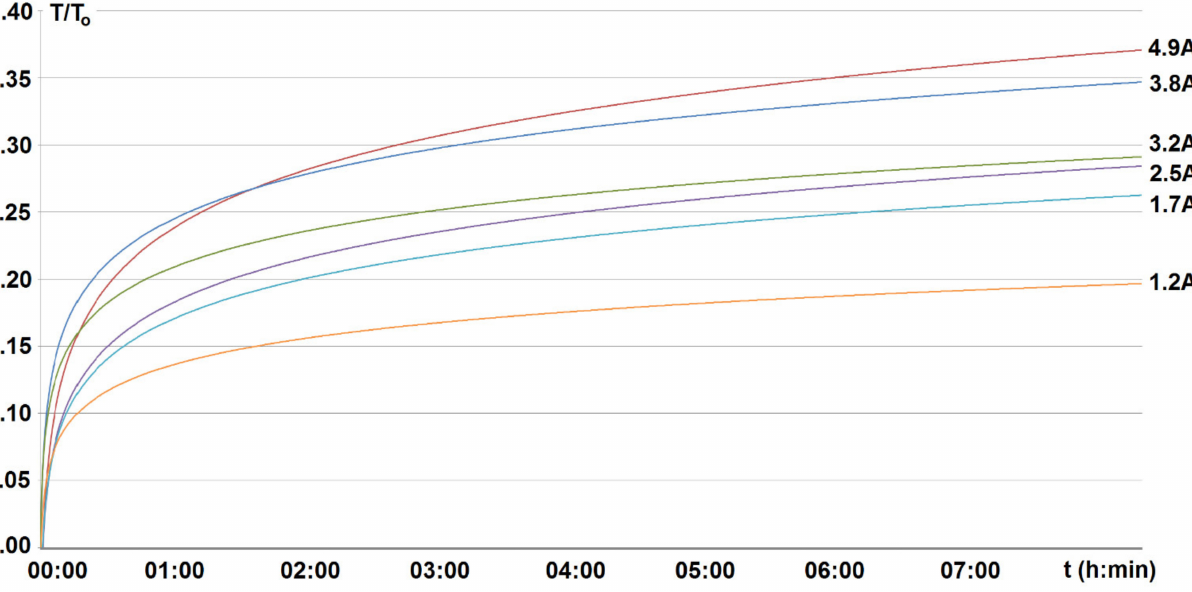
Figure 9. Increase in cell temperature T (T1 sensor) during discharge (to the minimum voltage value U min equal to 2.5 V) for various load currents under free room conditions. (T 0 = 22 ◦